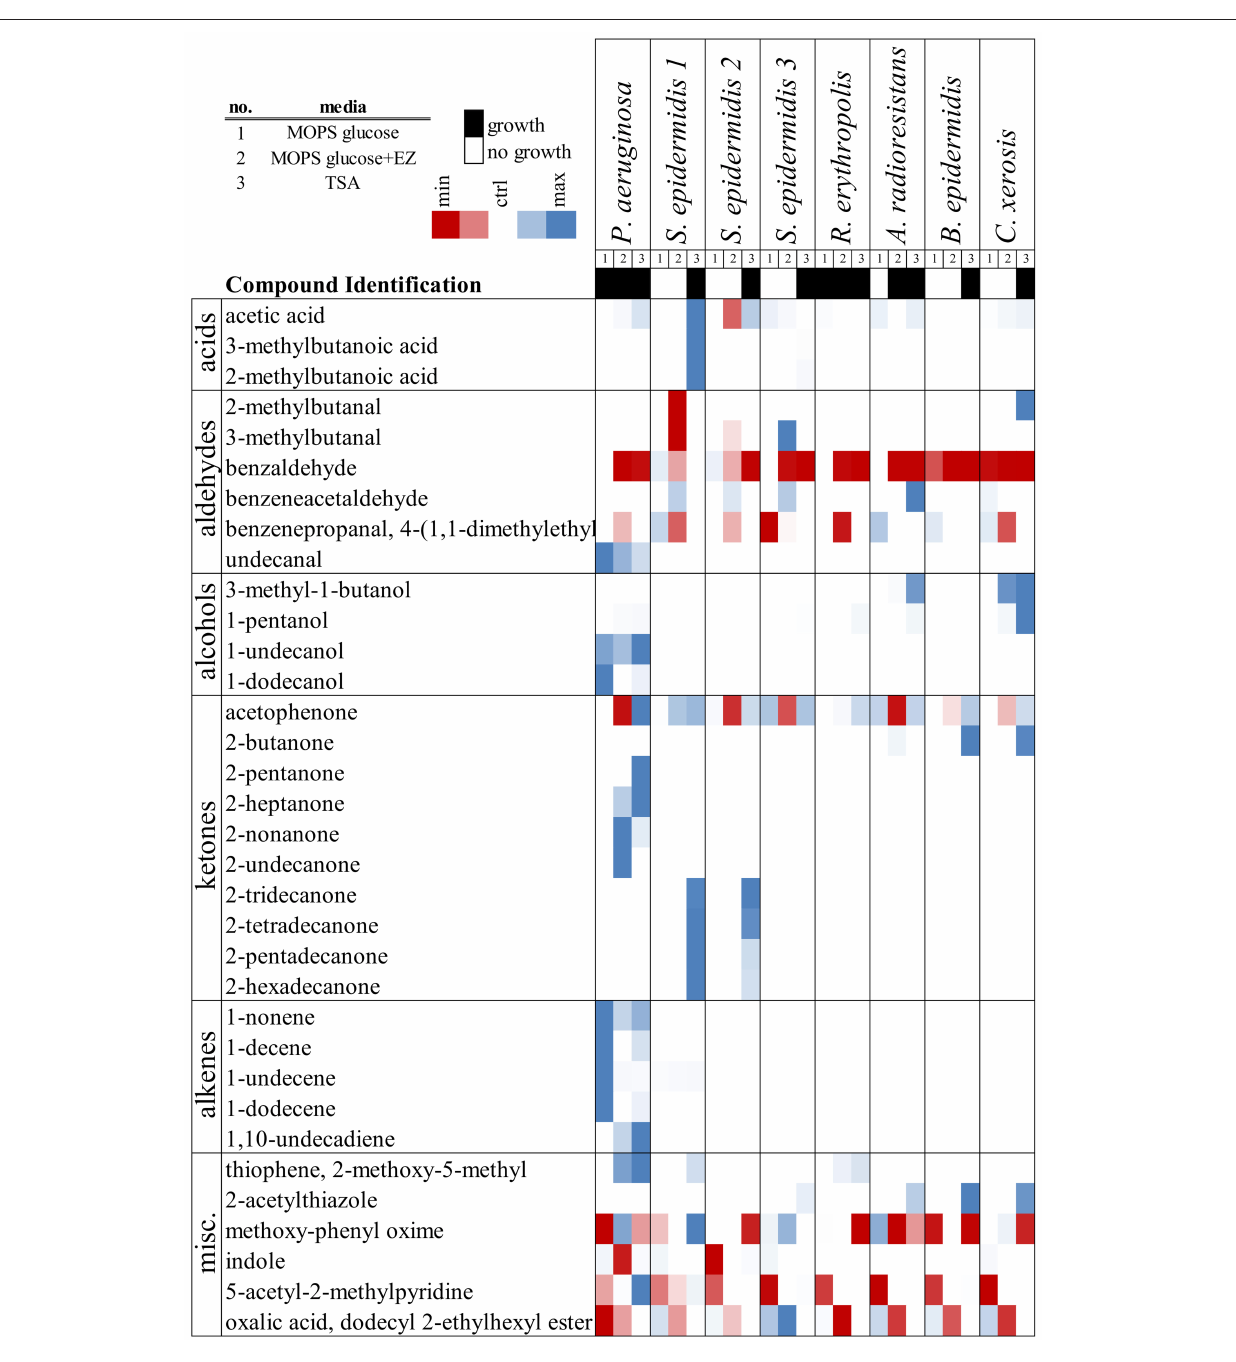
FIGURE 5 | Volatiles from human skin microbiome representatives. Heat map scaled to show relative peak intensities across samples. Growth was determine from visual identification of colonies and is indicated for each media condition. Putative peak identifications are listed and grouped by functional